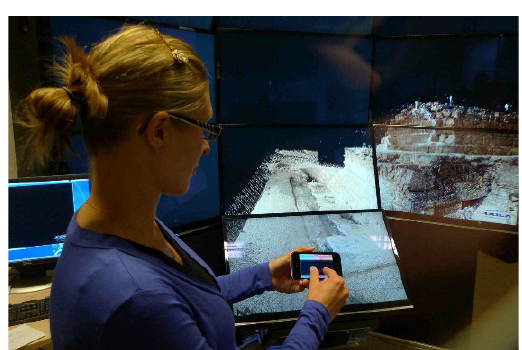
Figure 28. NexCAVE running CGLX, controlled by multi-touch iPhoneapplication,showingLIDAR-scannedimagecon- structed by Vid Petrovic. Photo: Tom DeFanti.